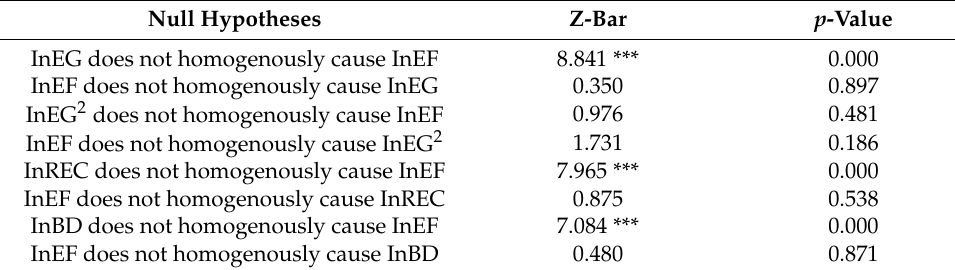
Table 9. The results of Panel Causality assessments.